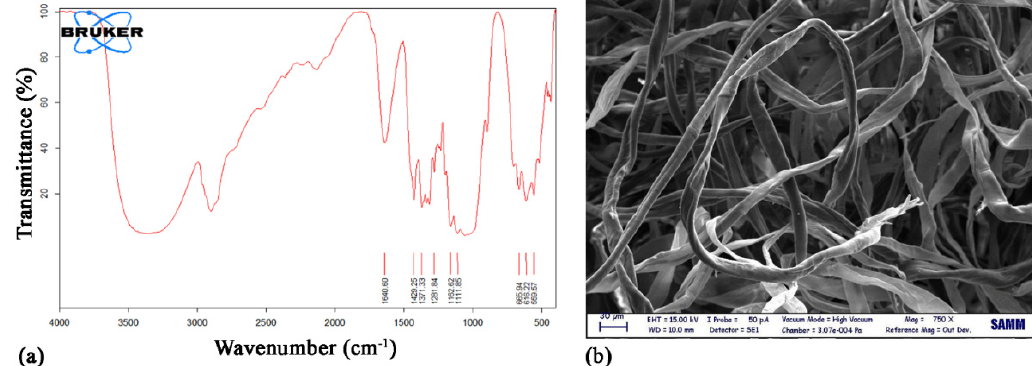
Figure 1. ( a ) FT-IR and ( b ) SEM analyses of cotton wool.